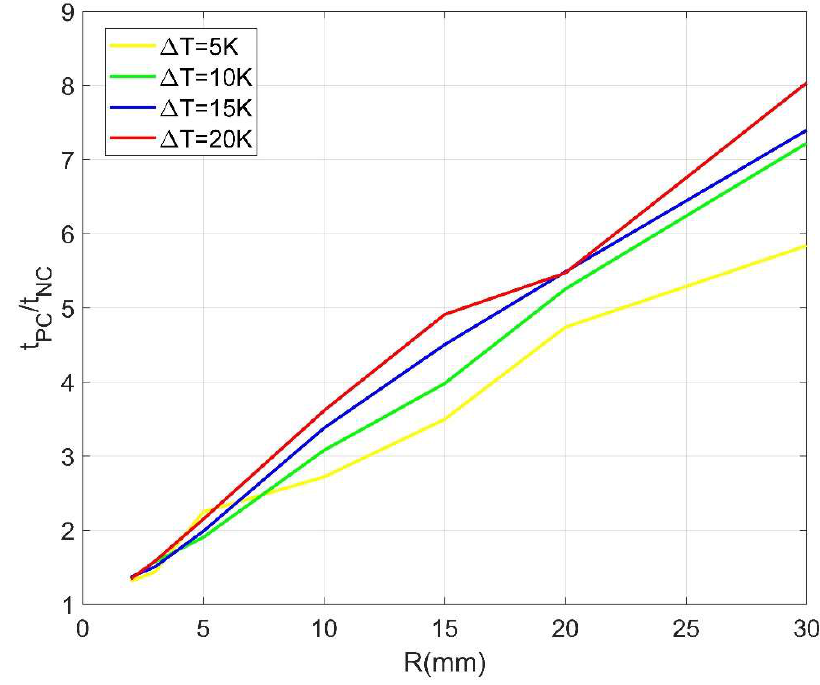
Figure 12. Variations of TMT ratio for different sphere sizes and heating temperatures.